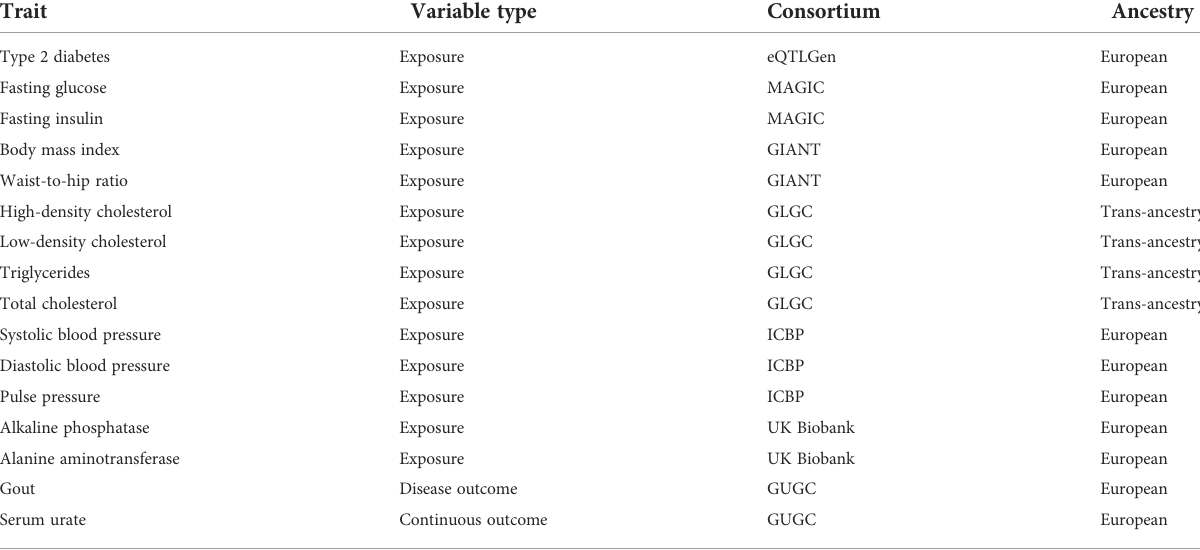
TABLE 1 Related information of included traits in the Mendelian randomization